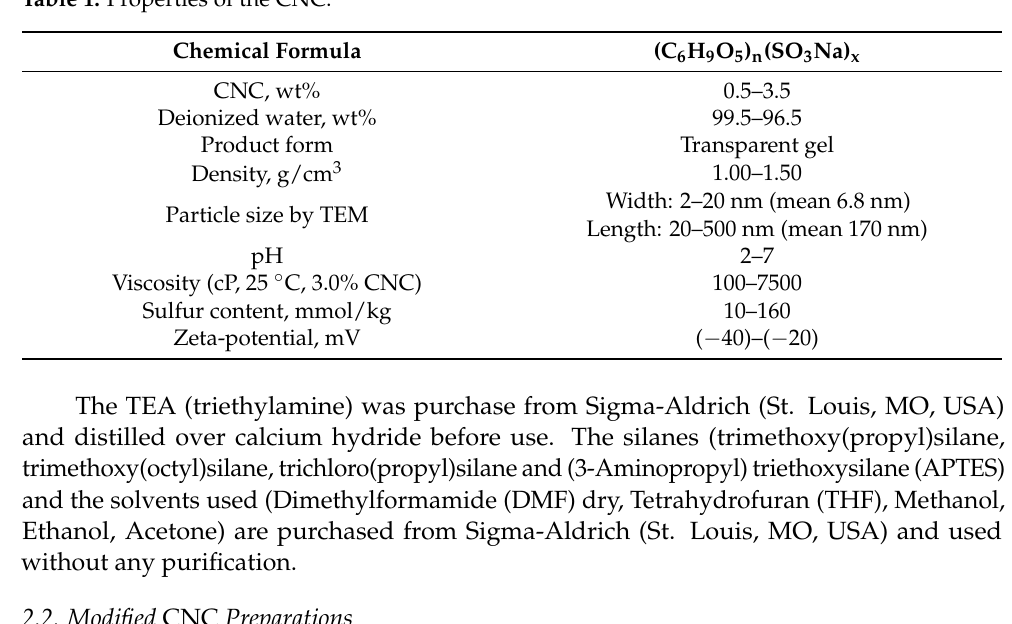
Table 1. Properties of the